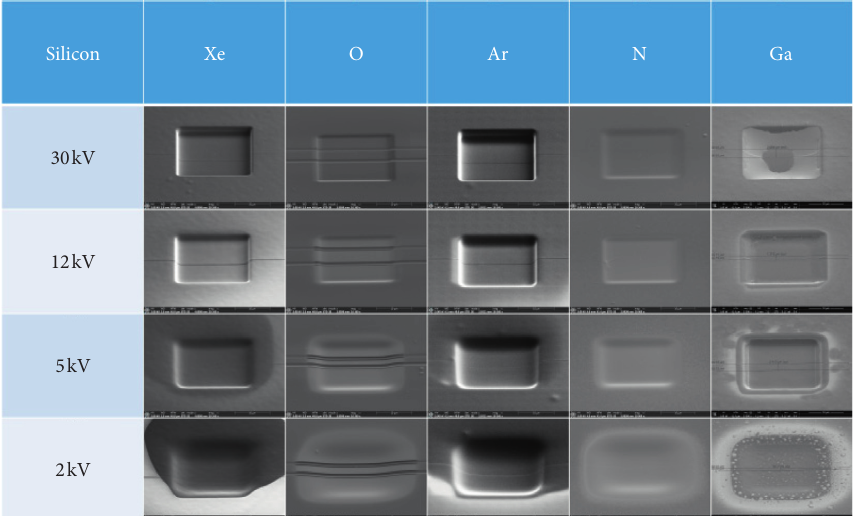
Figure 15: All images of silicon milled with different ion species at varying energies. Area is held constant at 20 µ m 2 . For beam current values, refer Table 1. All images were captured with a horizontal field width of 41.4 µ m.